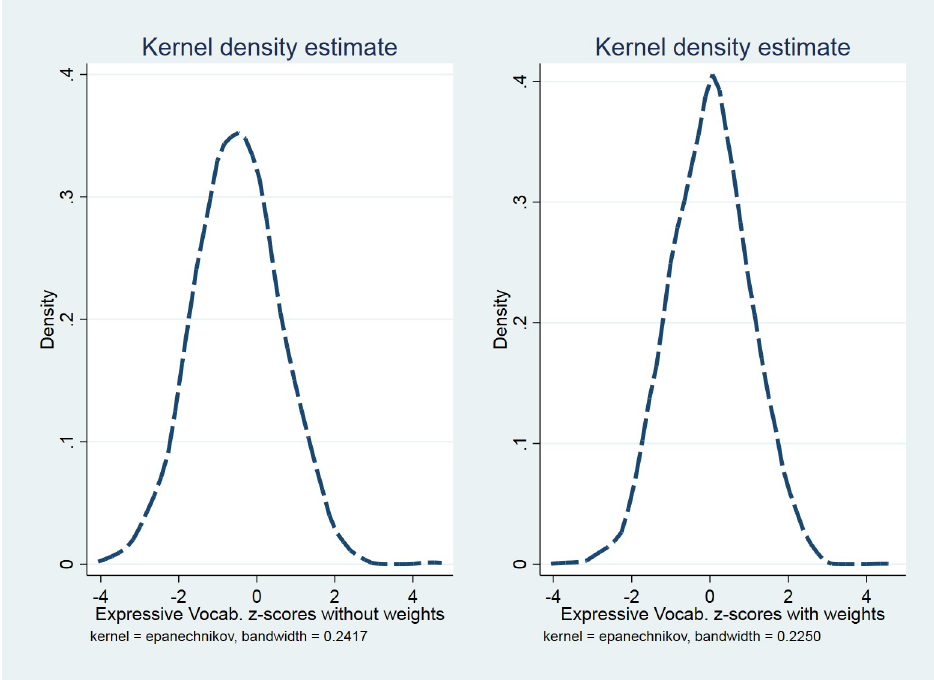
Fig 6. Expressive one word vocabulary standard scores distributions. Distribution of the Expressive One Word Vocabulary standard scores that resulted after the optimisation of the test’s raw scores without weights (left) and with weights